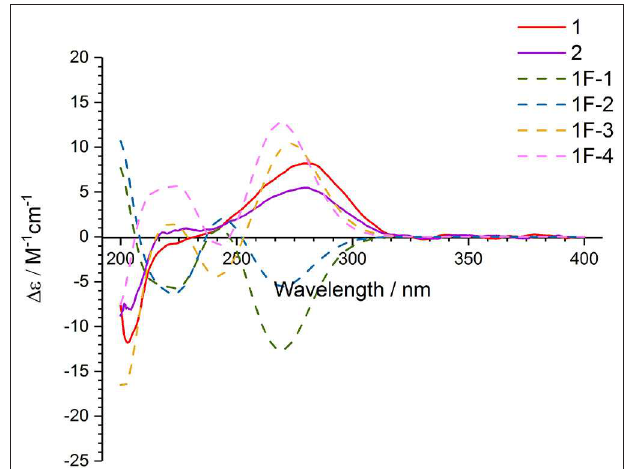
FIGURE 7 | The experimental ECD spectra of 1 – 2 and calculated ECD spectra of 1F-1 – 1F-4 .